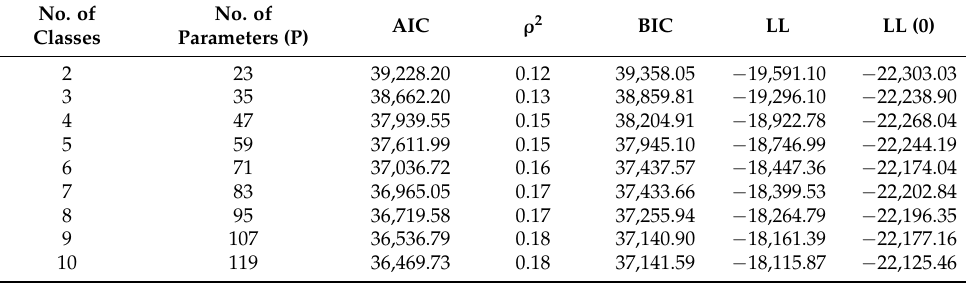
Table 3. Comparison of LC model with different number of